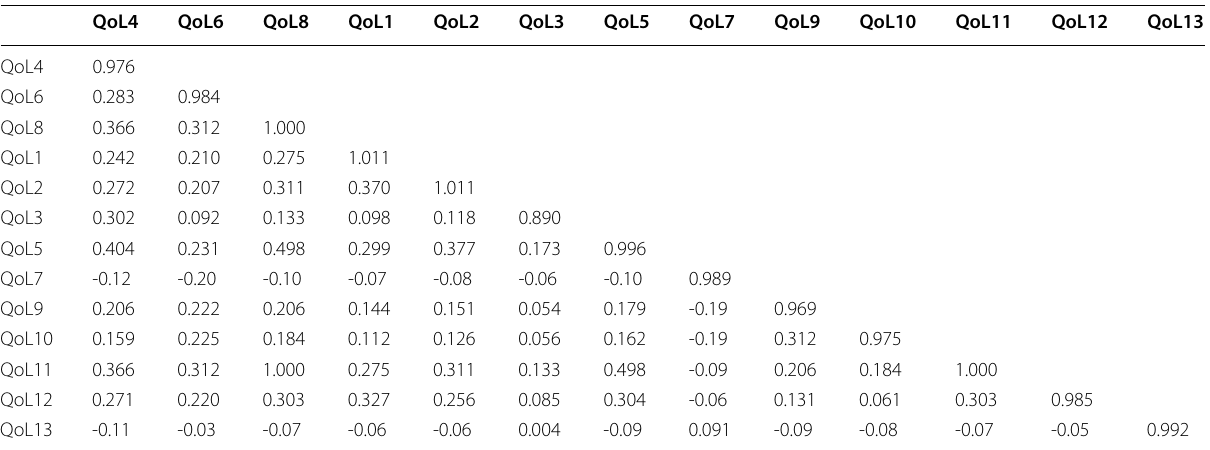
Table 3 The covariance